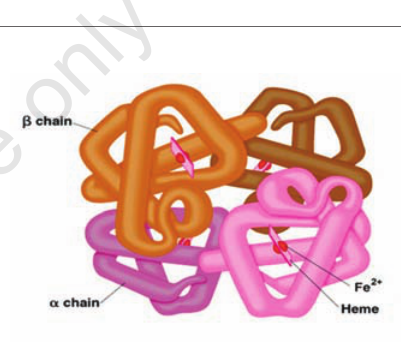
Figure 5. a = Alpha Chains. The a -globin genes are on chromosome 16. β =Beta Chains. The β -globin genes are on chromo- some 11. Fe 2+ = Ferrous indicates a bivalent iron compound (+2 oxidation state), as opposed to ferric, which indicates a triva- lent iron compound (+3 oxidation state). Heme = is a prosthetic group that consists of an iron atom contained in the center of a large heterocyclic organic ring called a por- phyrin . Not all porphyrins contain iron, but a substantial fraction of porphyrin- containing metalloproteins have heme as their prosthetic group; these are known as